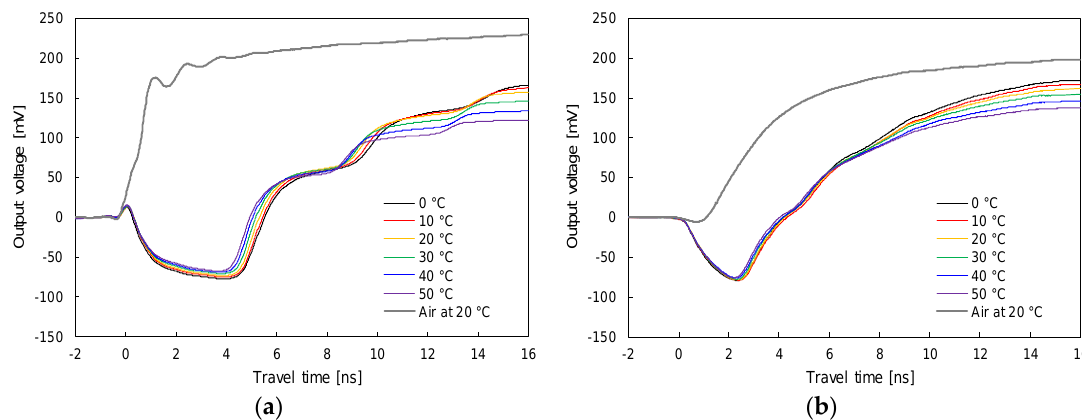
Figure 7. Signals in distilled water at different temperatures measured using the: ( a ) TDR probe; ( b ) TDCP probe.